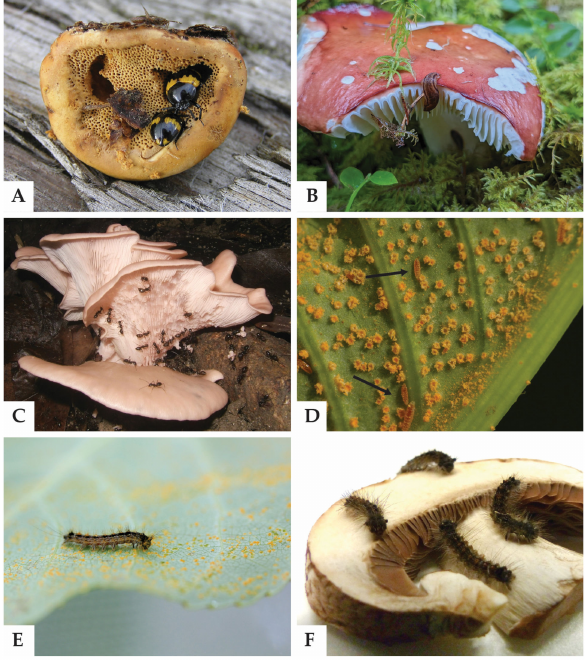
Figure 1. Examples of mycophagy in invertebrates. ( A ) Diaperis boleti tenebrionid beetles (Coleoptera) feeding on Fomitopsis pinicola (Polyporales, Agaricomycetes) in Białowie˙za Forest, Poland. Photo: Beentree, Wikimedia Commons. ( B ) A slug (Gastropoda) on Russula sp. (Russulales, Agaricales) in Stožec, Czech Republic. Photo: Michiel D. de Groot. ( C ) Euprenolepis procera ants (Hymenoptera) are known for their Pleurotus -harvesting (Agaricales, Agaricomycetes) behavior in southeastern Asia. Photo: Volker Witte, Wikimedia Commons. ( D ) Mycodiplosis midges (Diptera) (arrows) feeding on Uromyces ari-triphylli aecia (Pucciniales, Pucciniomycetes) in Minnesota, USA. Photo: iNaturalist observation #79142892 by davidenrique. ( E ) A gypsy moth caterpillar ( Lymantria dispar , Lepidoptera) consuming spores of the rust fungus Melampsora laricis-populina (Pucciniales, Pucciniomycetes) on a leaf of black poplar ( Populus nigra ). Photo: Fransizka Eberl. ( F ) The same L. dispar caterpillars were also observed feeding from basidioma slices of Agaricus bisporus in laboratory setting (Agaricales, Agaricomycetes) (F. Eberl and S.B Unsicker, unpubl.). Photo: Fransizka